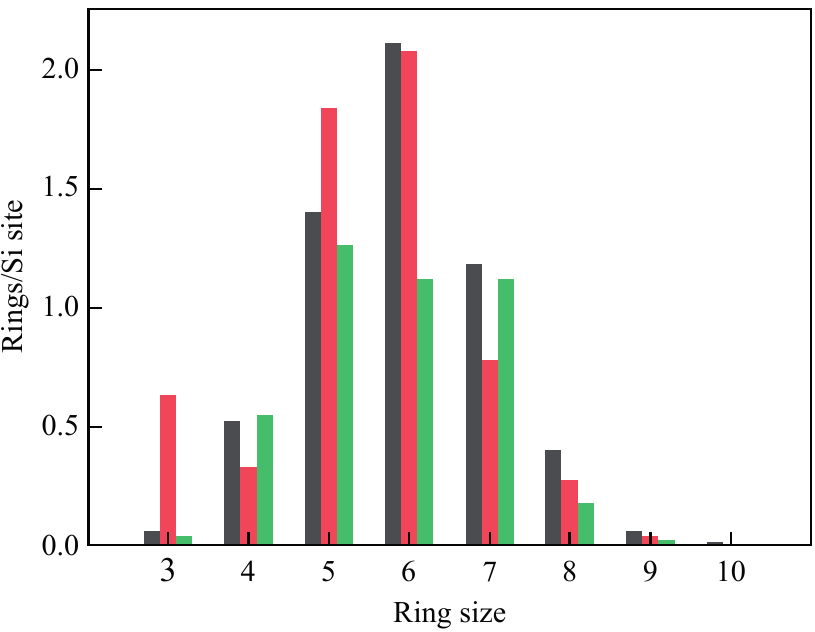
Figure 3. Shortest-path ring statistics of the silica models reported by Rino et al. (grey) [31], Pasquarello and Car (red) [48], and Giacomazzi et al. (green)